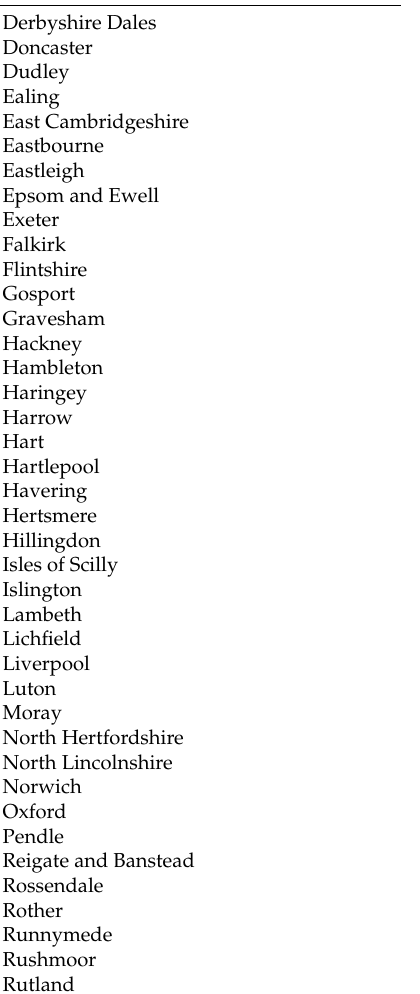
Table A8. Cont. Local